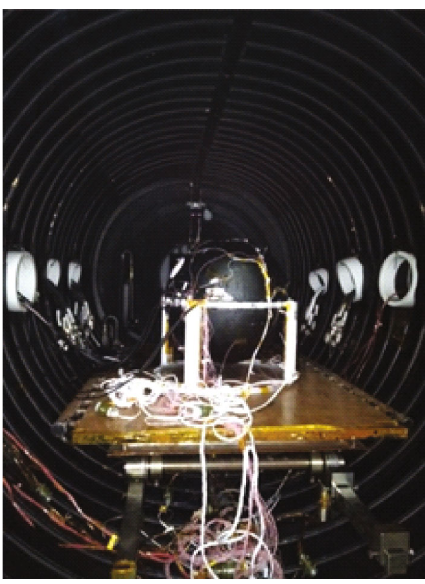
Figure 13: Thermal test scene. Table 5: Parameters of the heating